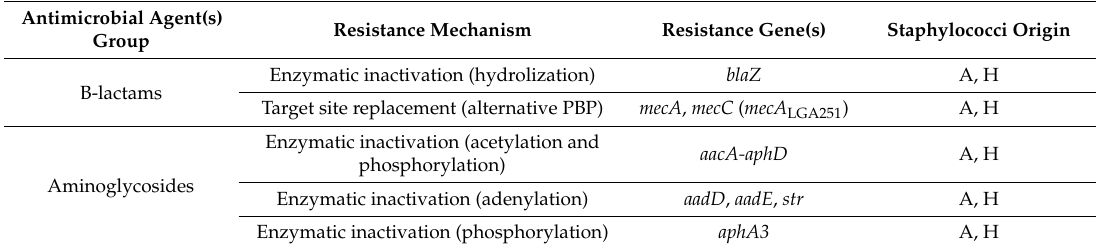
Table 3. Examples of AMR-genes identified in Staphylococci from animal and/or human origin. Antimicrobial Agent(s)